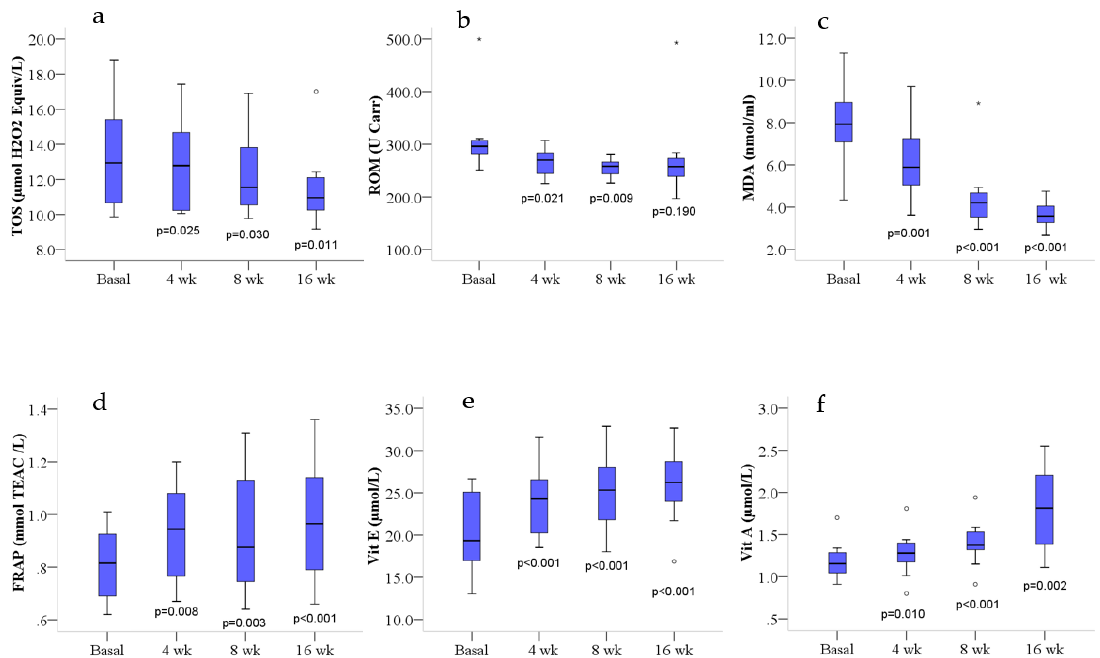
Figure 2. Blood oxidative profile at basal level and after 4, 8 and 16 weeks of treatment. Box plots show median (horizontal line in the box), 25th and 75th percentiles (edges of box), maximum and minimum values (whiskers) and outliers ( ◦ , *) of: ( a ) total oxidant status (TOS), ( b ) reactive oxygen metabolites (ROM), ( c ) malondialdehyde (MDA), ( d ) ferric reducing ability of plasma (FRAP), ( e ) vitamin E (Vit E) and ( f ) vitamin A (Vit A) concentrations. p values measure the significance of differences compared with basal values (least significant difference); wk, weeks.